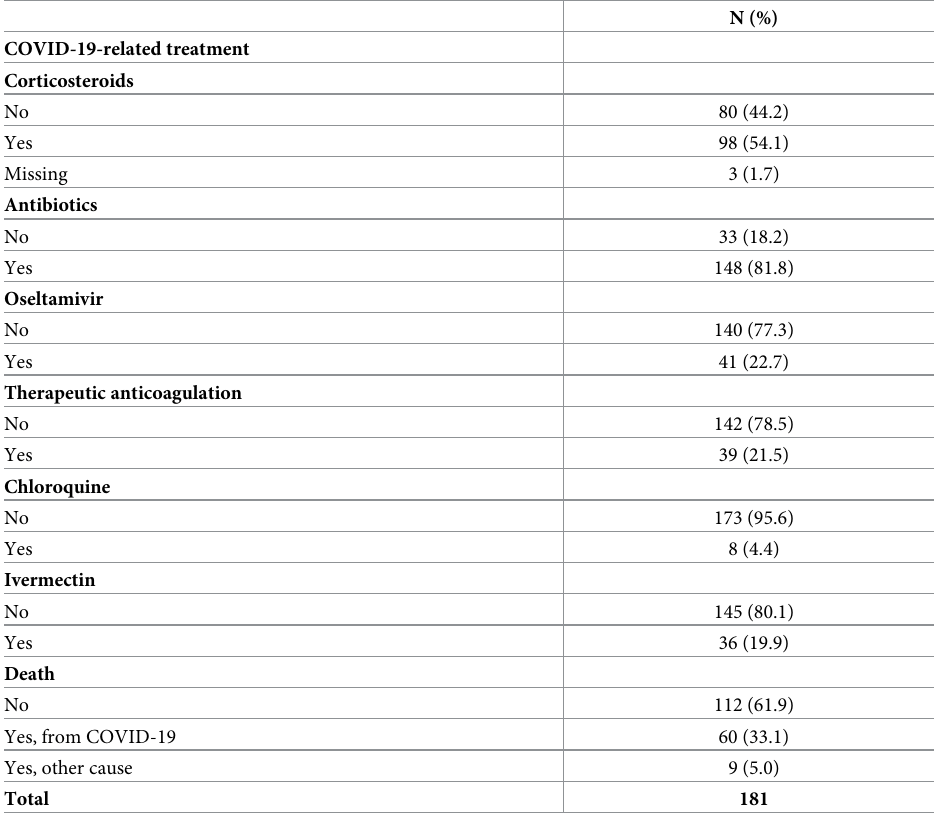
According to the multivariate analysis patients admitted due to COVID-19 symptoms (OR 2.3, 95% CI—1.1 to 4.9, P = .027) and with two (OR 10.0, 95% CI—3.6 to 28.3, P < .001) or more metastatic sites (OR 14.8, 95% CI—4.1 to 53.2, P < .001) showed a significantly higher risk of COVID-19-specific